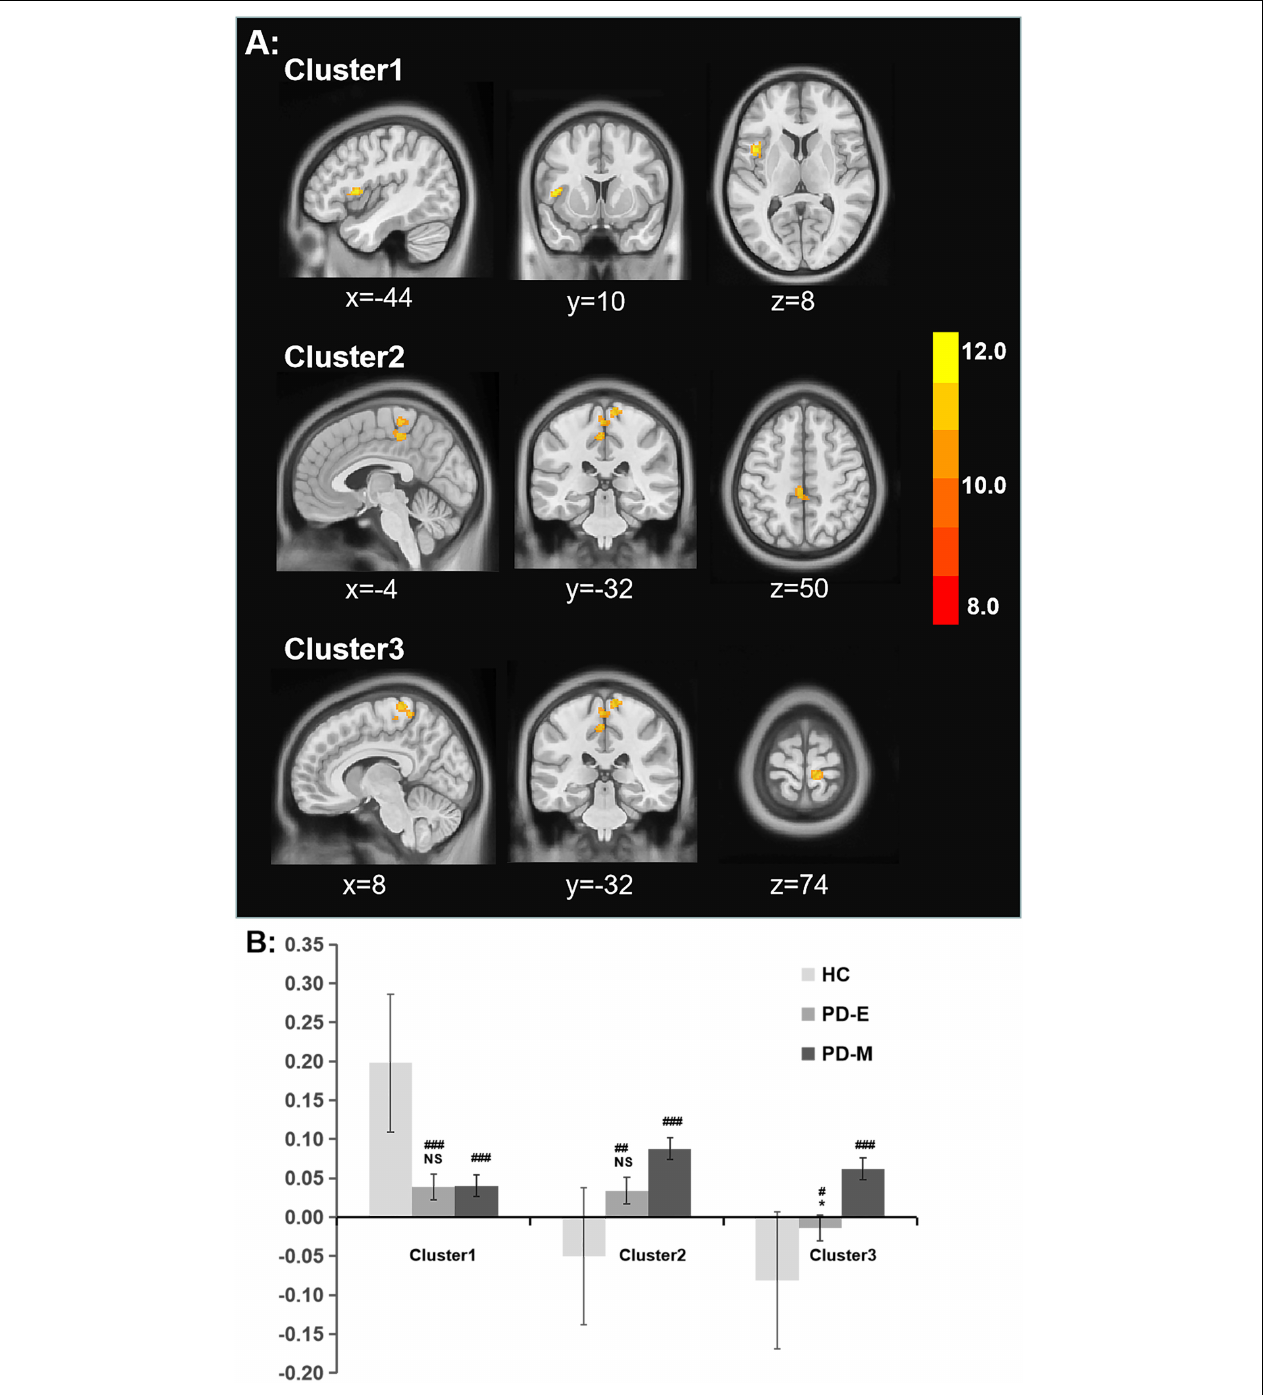
FIGURE 2 | (A) Significant alterations of rsFC between the left SI and whole brain among all groups. (B) The bar plot of comparisons of functional connectivity between groups. * p < 0.05 vs the PD-M group, # p < 0.05; ## p < 0.01; and ### p < 0.001 vs the HC group. rsFC, resting-state functional connectivity; SI, substantia